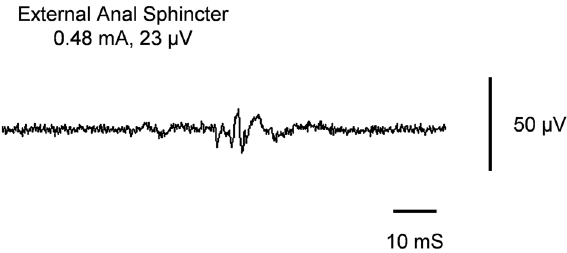
Figure 2. Intraoperative trigger electromyography during the surgery. The freezing screen presented a representative external anal sphincter activity elicited by electrically stimulating a dorsal rootlet. This stimulated rootlet is defined as sphincter-associated input rootlet